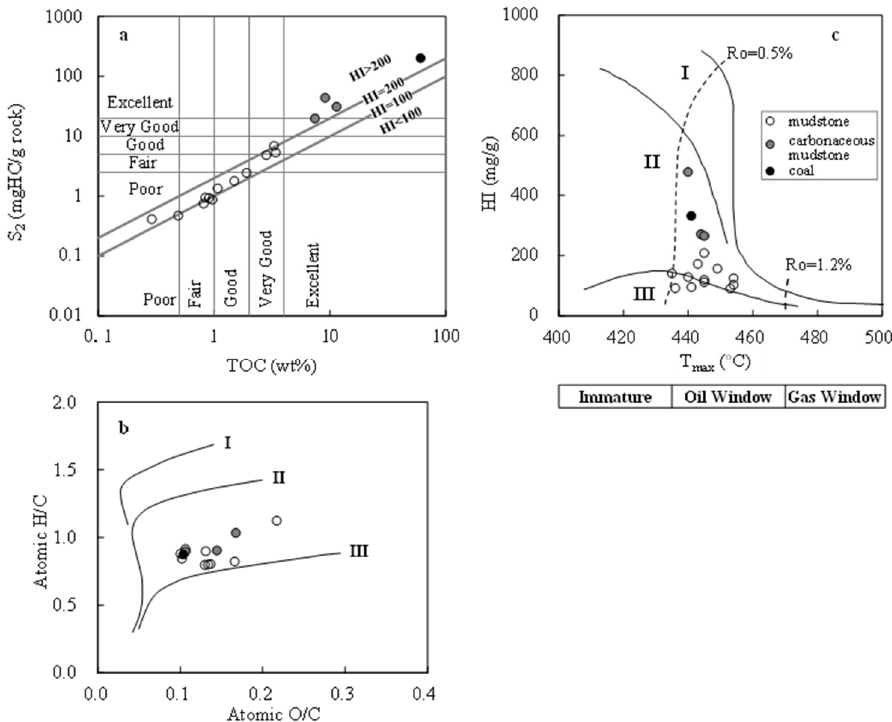
Figure 3. Cross-plots of S 2 versus TOC ( a ), atomic H/C versus O/C ( b ), and HI versus T max ( c ) for source rocks of the Pinghu Formation from well W-3, Xihu Sag. See Figure 3c for the legend.